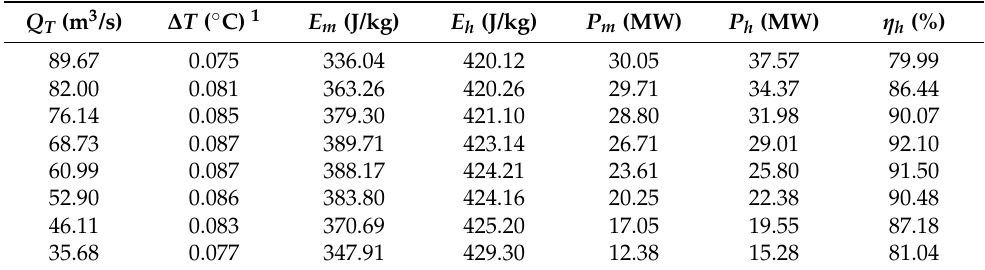
Table 10. Summary of results, application of Thermodynamic Method.